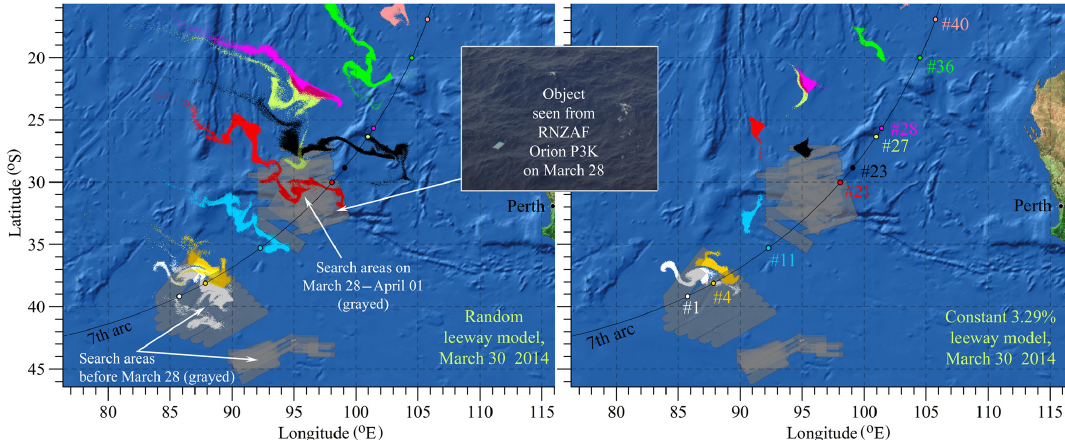
Figure 5. Snapshots of particle ensembles originating from several locations (indicated with corresponding colours of ensembles) on 30 March for two models and the areas surveyed by 2 April. Sources of the aerial search maps and photograph: JAAC (2014), AMSA